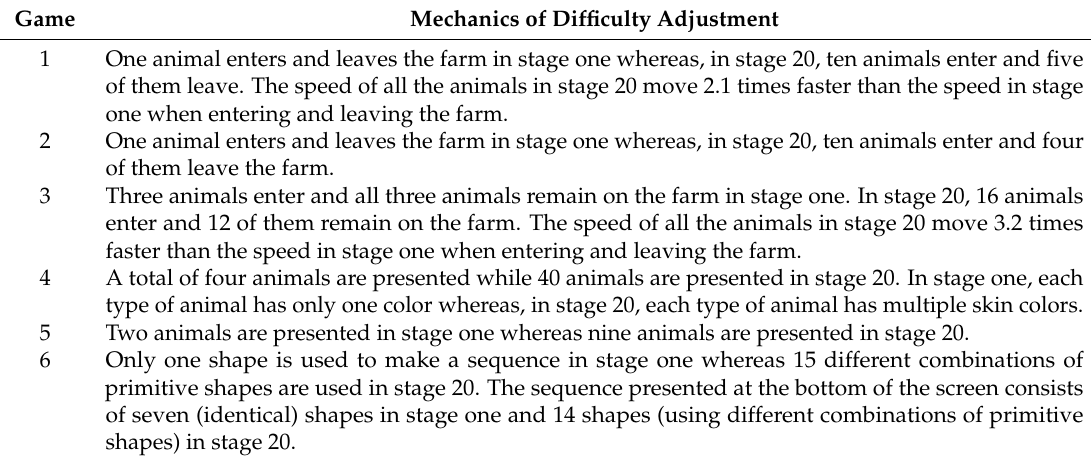
Table A1. The mechanics of how difficulty levels are adjusted for Neuro-World games. Game Mechanics of Difficulty